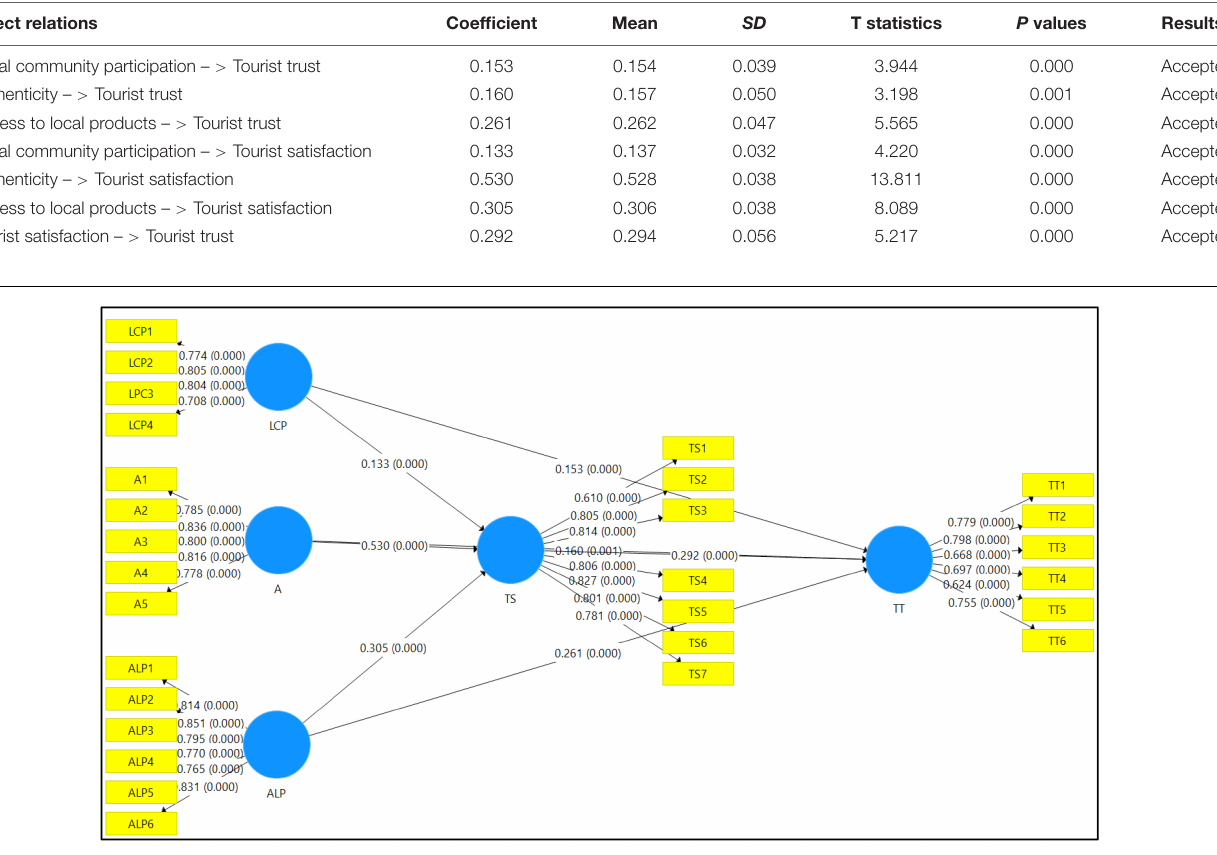
FIGURE 2 | Structural equation model.